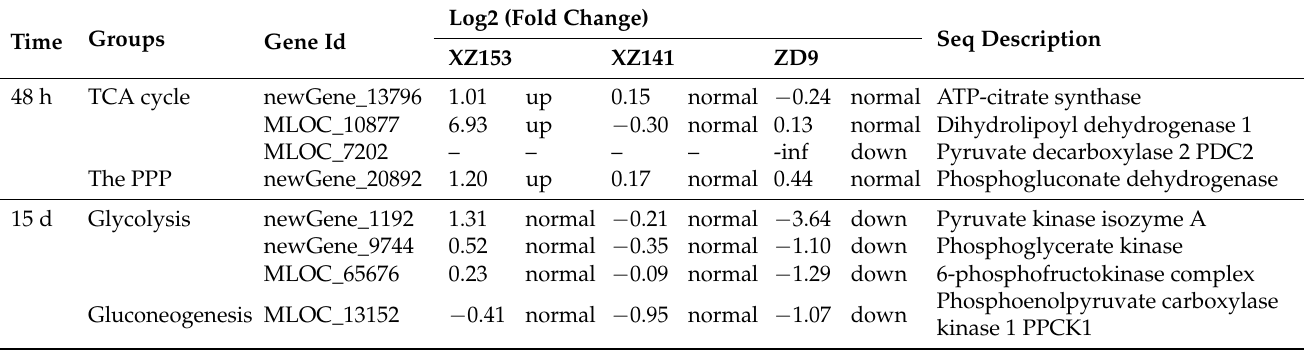
Table 4. The DEGs involved in four metabolic pathways at 48 h and 15 d after being exposed to LK